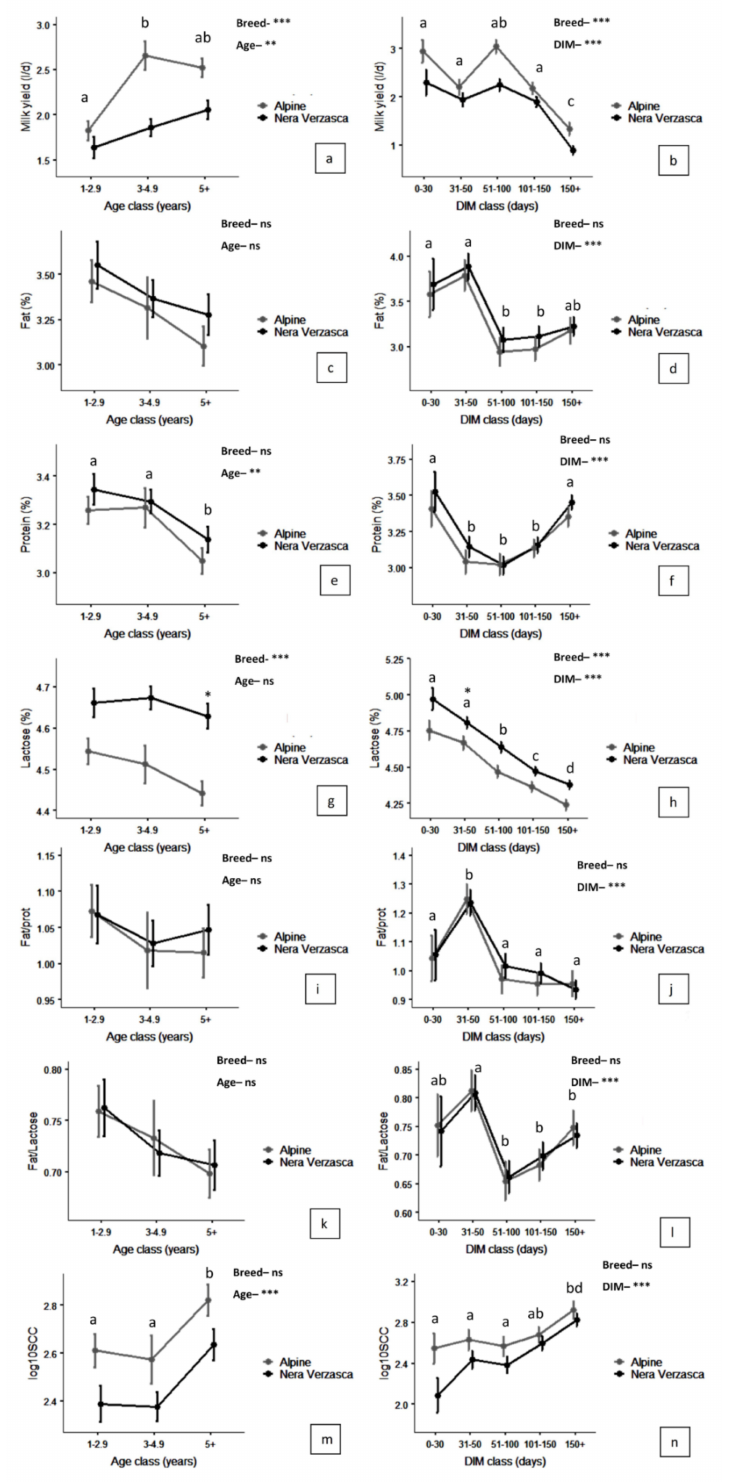
Figure 1. Patterns of milk variables in Alpine and Nera di Verzasca goat breeds for age and days in milk (DIM), respectively. The effects of breed, age and DIM have been evaluated on milk yield ( a , b ), milk fat % ( c , d ), milk protein % ( e , f ), milk lactose % ( g , h ), milk fat/protein ratio ( i , j ), milk fat/lactose ratio ( k , l ) and on somatic cell count ( m , n ). Letters indicate a significant difference in age or DIM groups. Asterisks in the graphs indicate the age/DIM period with significant differences between breeds. Data were resumed as mean values and standard error of